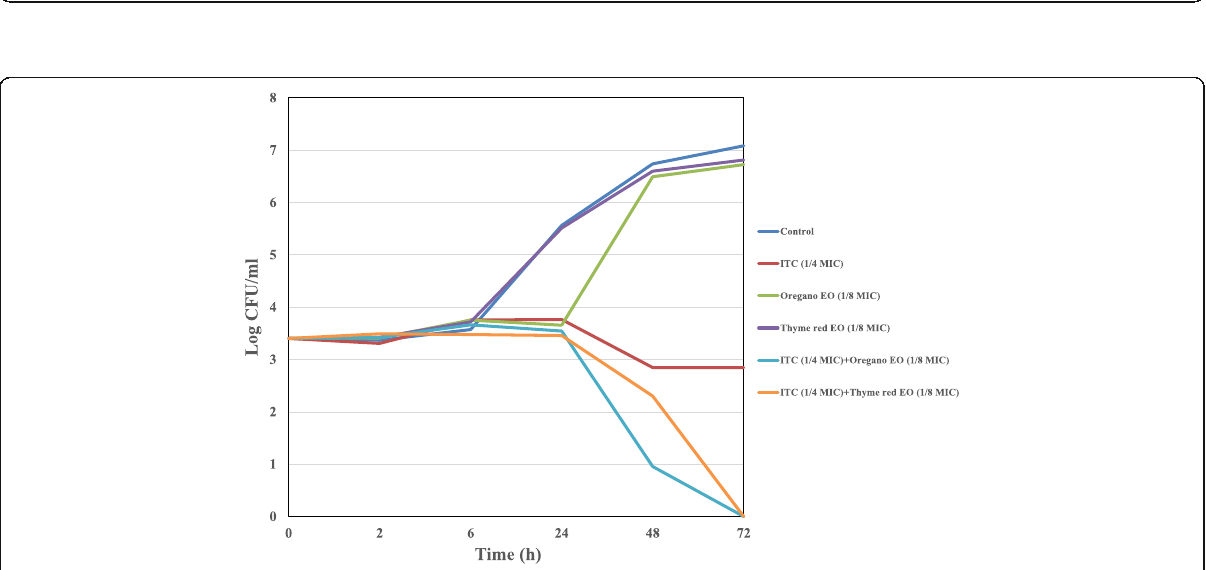
Fig. 2 Isobologram plots of ITC and EOs/EO main components against C.neoformans ADS 006 (azole not-susceptible strain). Points along the isobolograms represent the growth no-growth interface: fractional inhibitory concentration (FIC) values of ITC are plotted on x -axis, and FIC values of EOs/EO main components are plotted on y